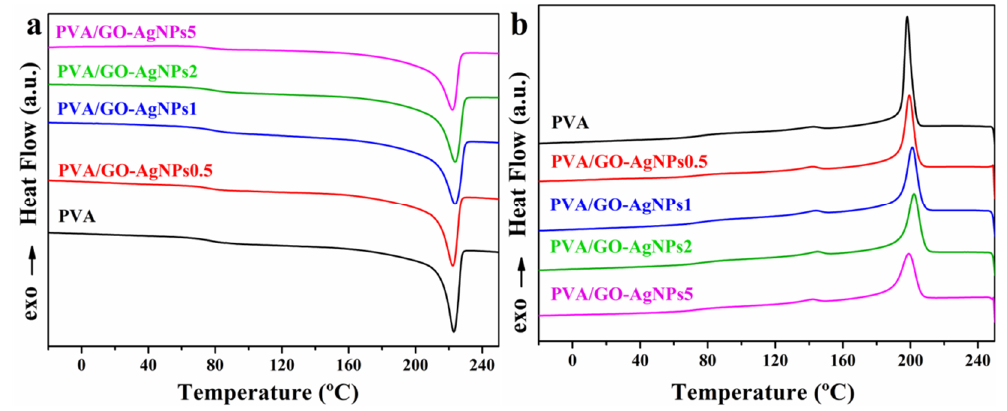
Figure 4. DSC curves of neat PVA and PVA / GO–AgNPs composites. ( a ) Second heating scan; ( b ) first cooling scan.